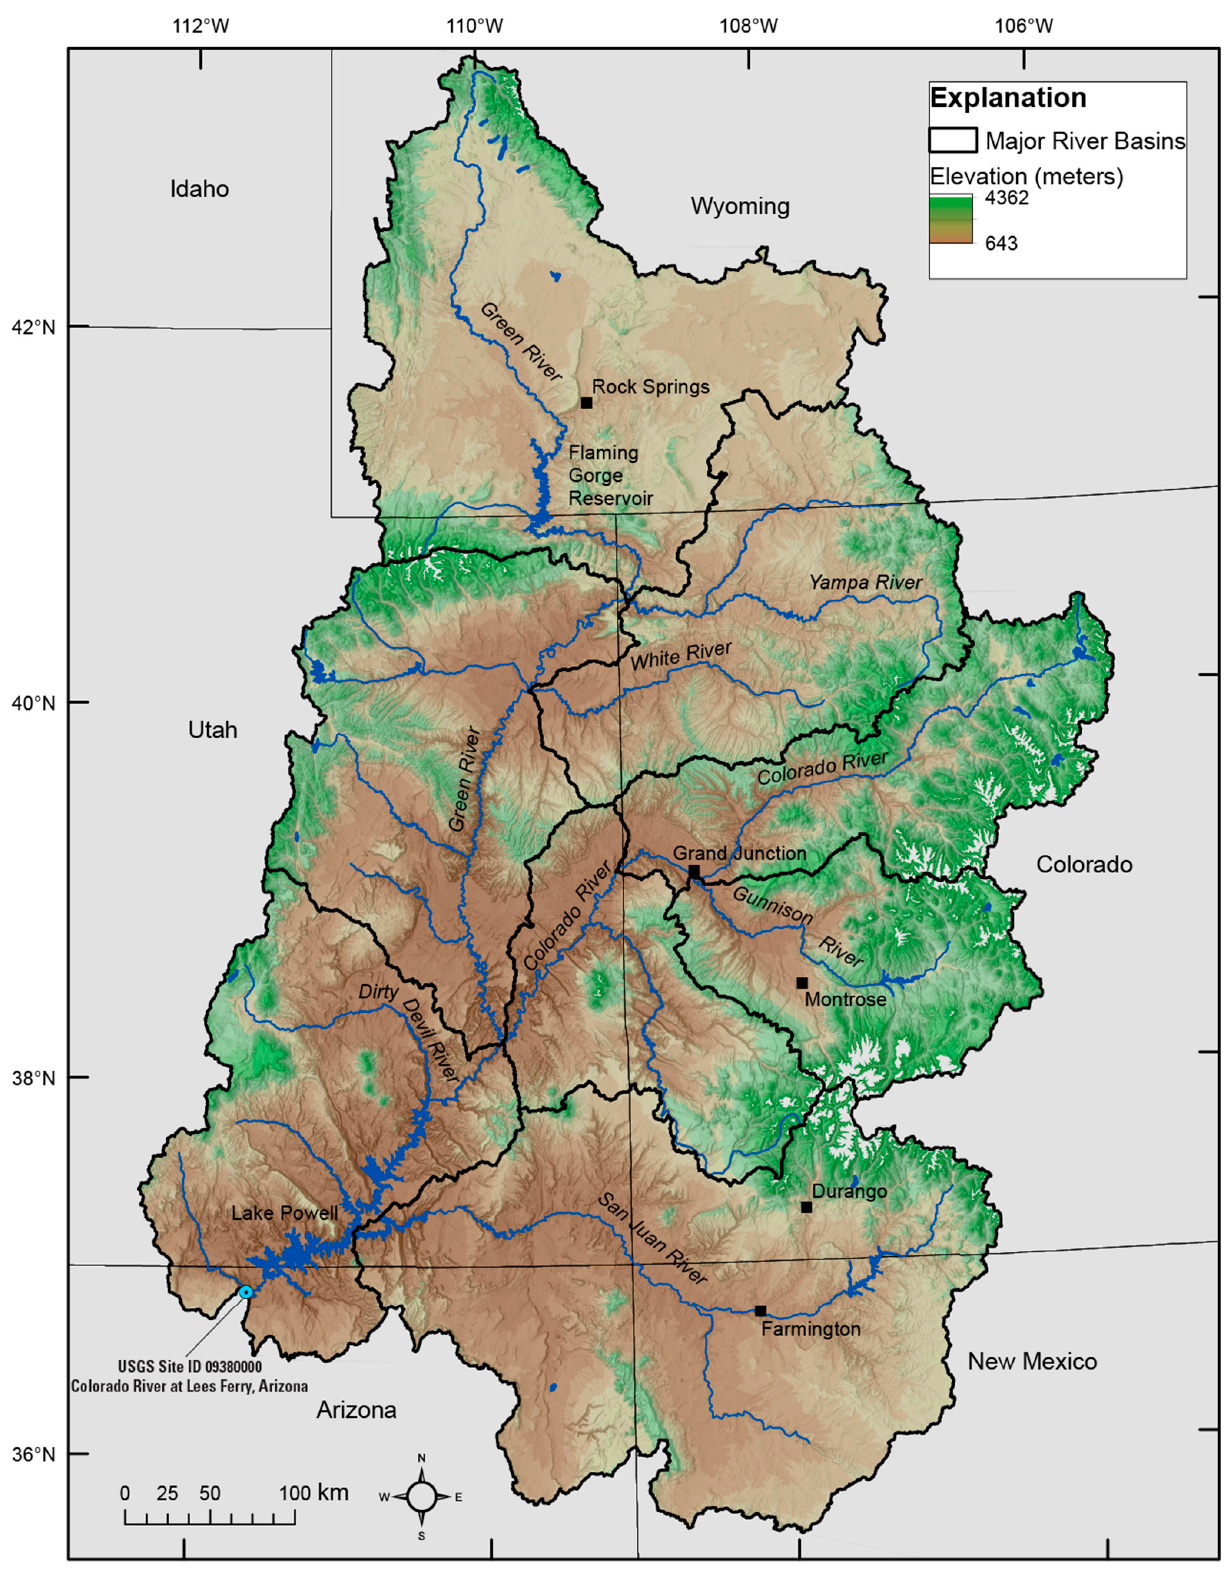
Figure 2. Map of the Upper Colorado River Basin showing major tributaries and sub-basins.